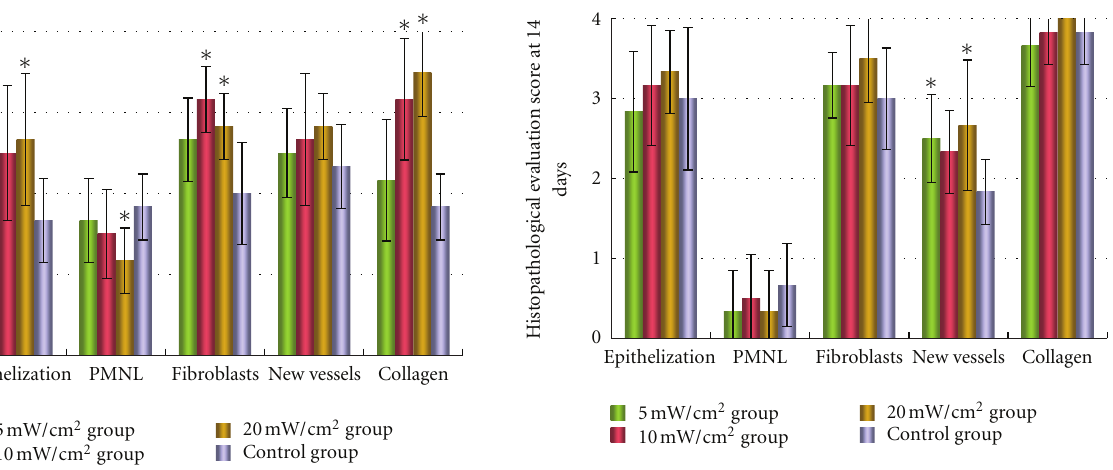
Figure 6: The semiquantitative histopathological evaluation score at 14 days after wounding. Asterisk means that this group has statistical di ff erence with control group ( P < 0 .